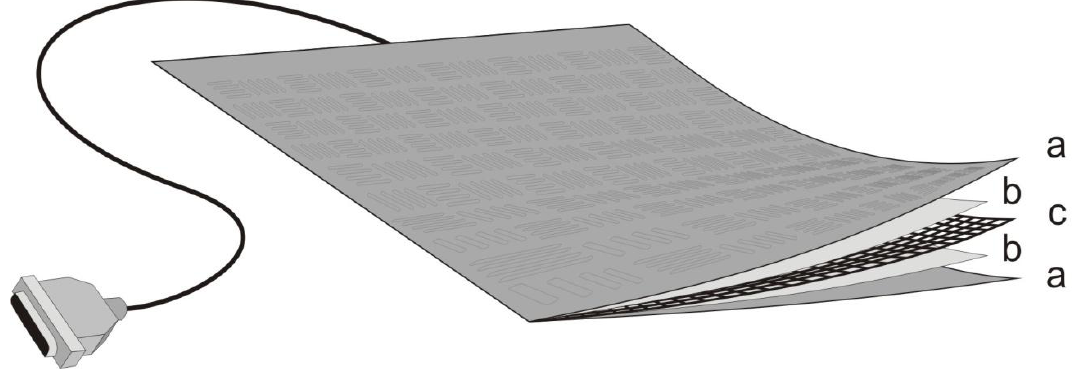
Figure 1. The structure of SaltoBras: 1a) anti-slip rubber film; 1b) flexible metallic plates and 1c) hollowed rubber